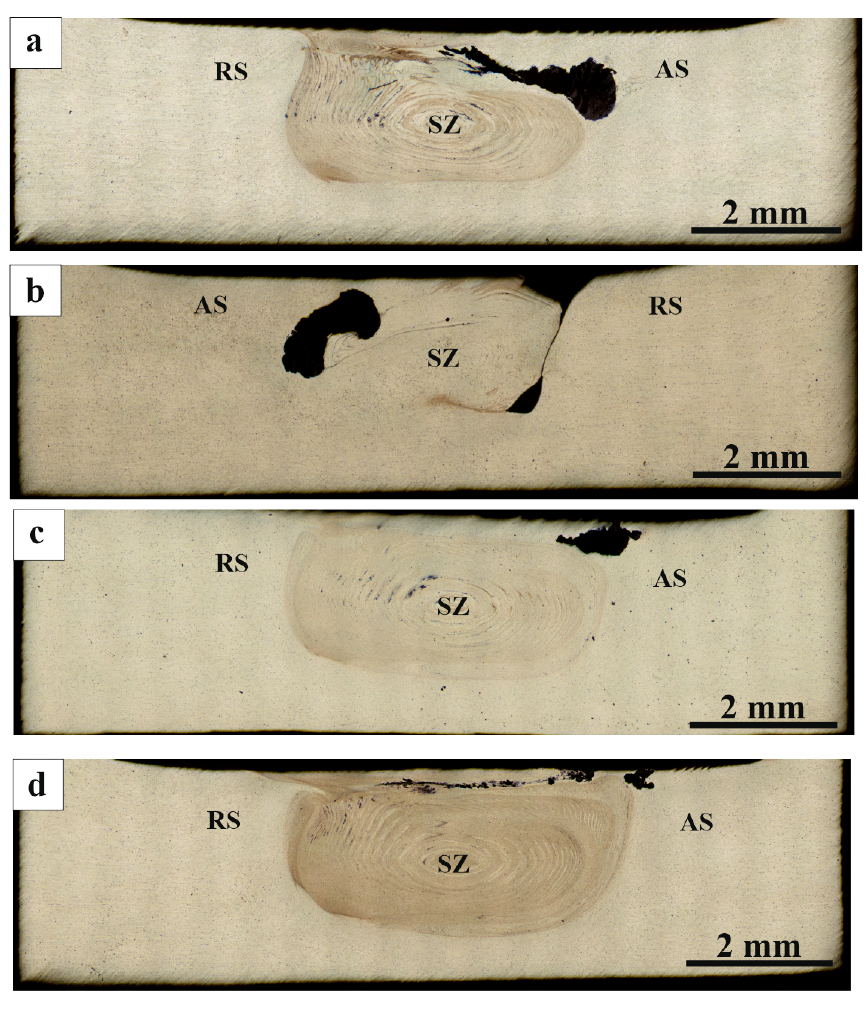
Figure 4. Macrostructure of the RPPs/AA5056 composite after: ( a ) 1st; ( b ) 2nd; ( c ) 3rd; and ( d ) 4th tool passes along the machining line. SZ—stir zone; RS—retreating side; AS—advancing side.